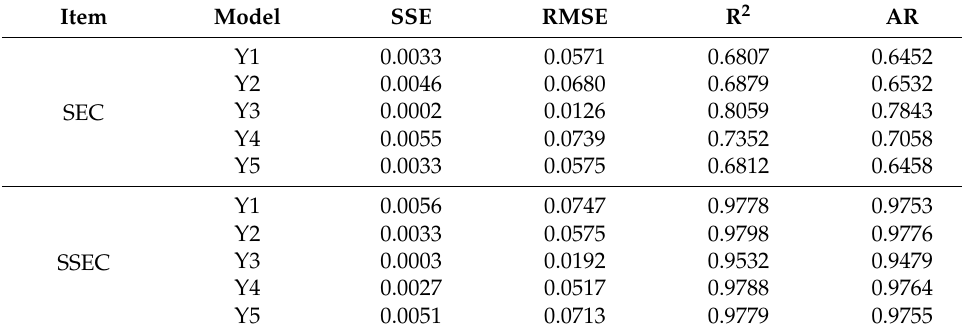
Table 9. Validation evaluation of the soil electrical conductivity construction model.